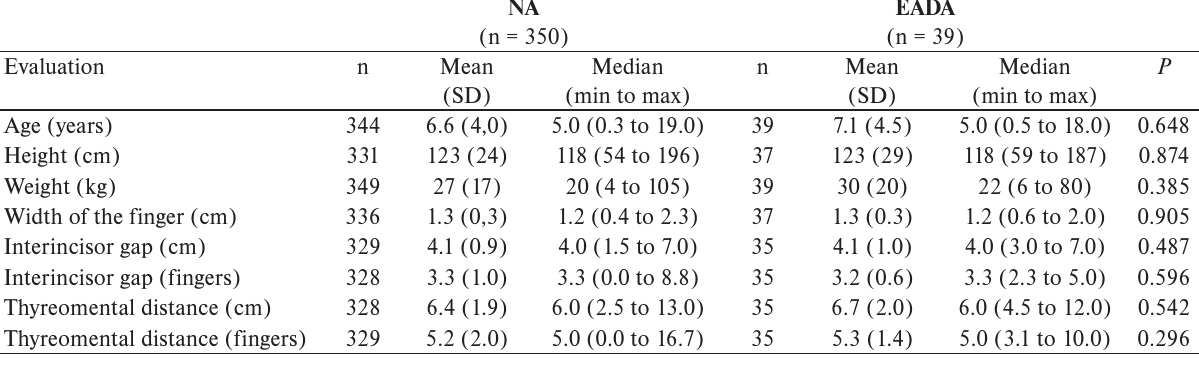
Table 4. Prediction test and clinical evaluation for